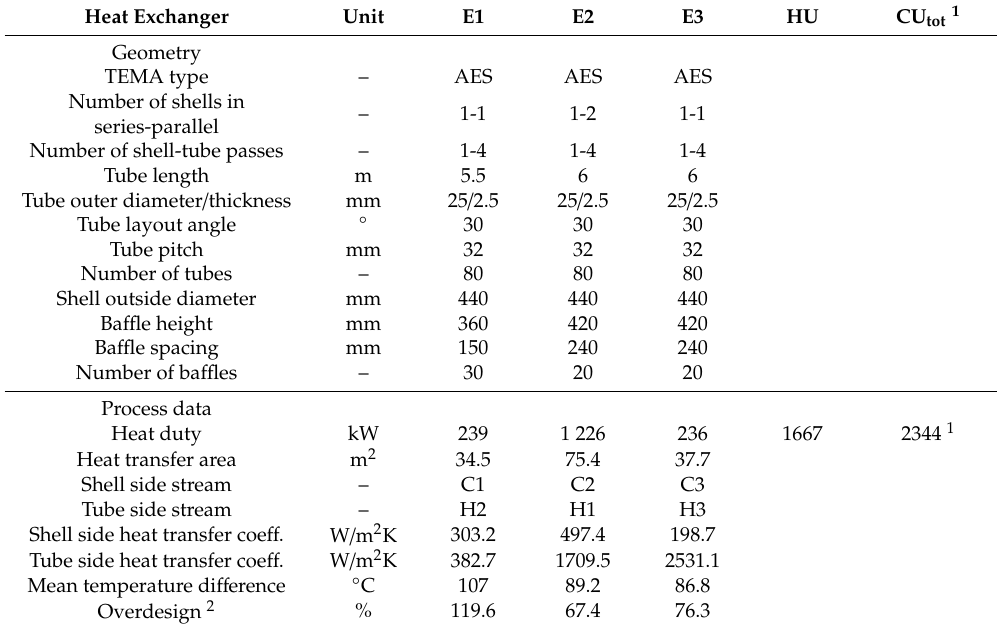
Table 1. The geometric and process characteristics of HEs employed in the current HEN.